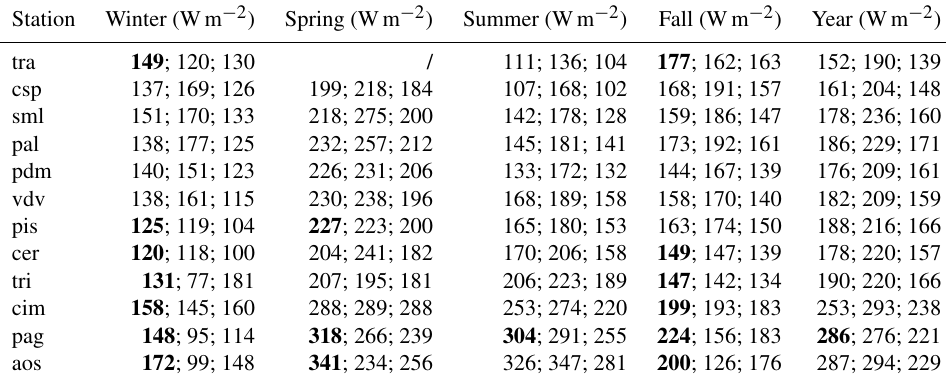
Table 6. RMSE (Wm − 2 ) for the RAMS-GHI 1-day hourly forecast (first number in each cell), 1-day persistence hourly forecast (second number in each cell) and RAMS-GHI 1-day hourly forecast after the MOS application for different seasons and stations (third number in each cell, see text for details). Bold style shows the cases when the RAMS-GHI 1-day hourly forecast has a worse performance compared to the 1-day persistence hourly